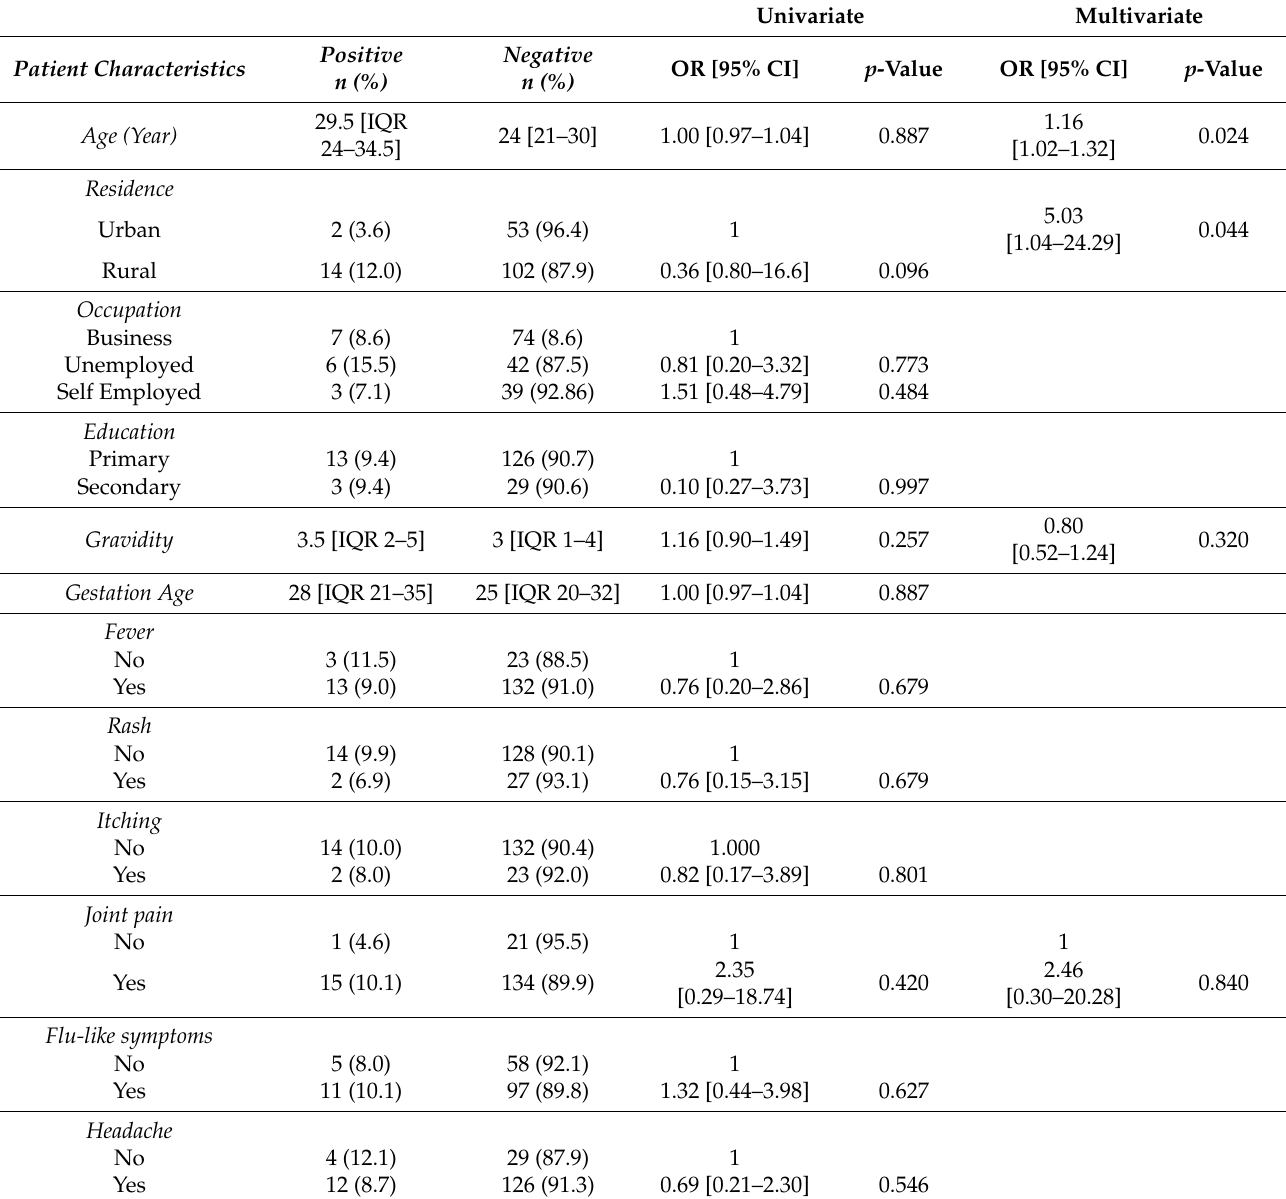
Univariate Multivariate